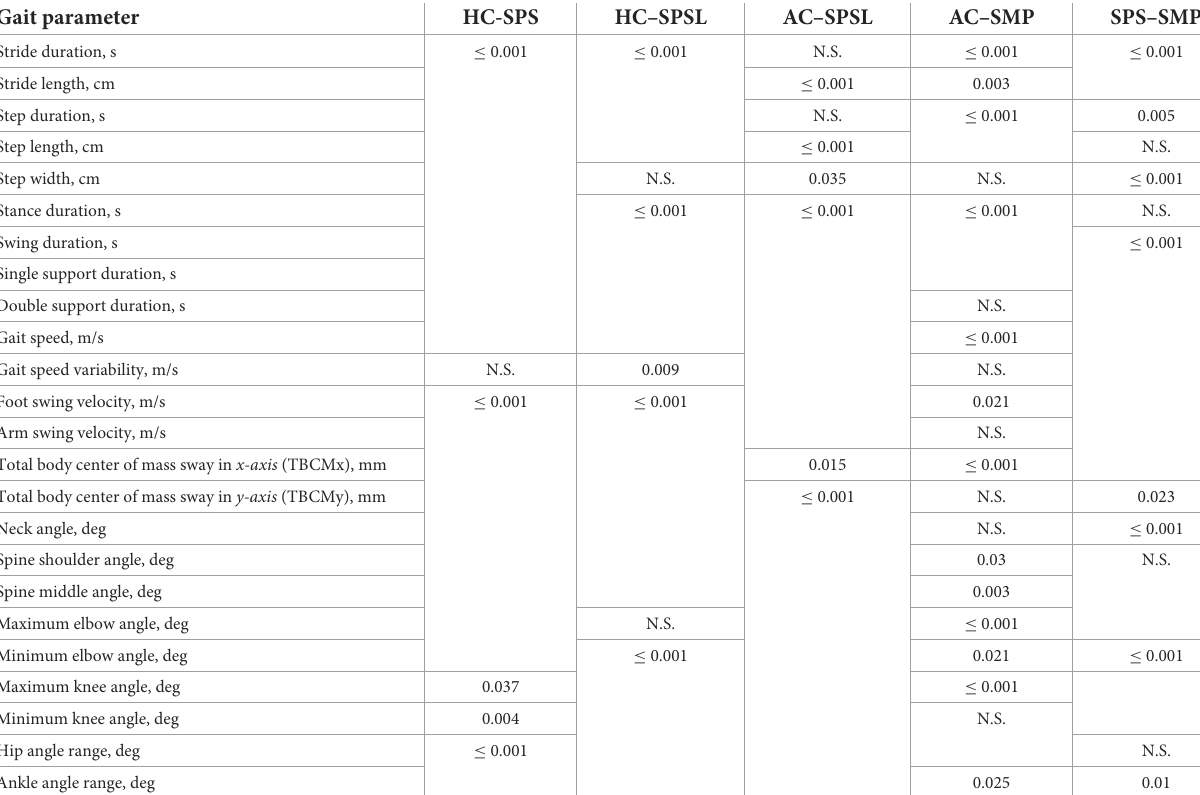
Table S.I. Results of the Conover-Iman test ( p -value) for the pairwise comparisons not presented in Table 3 between the six considered groups (HC, AC, SP, SPS, SPSL and SMP), for each gait